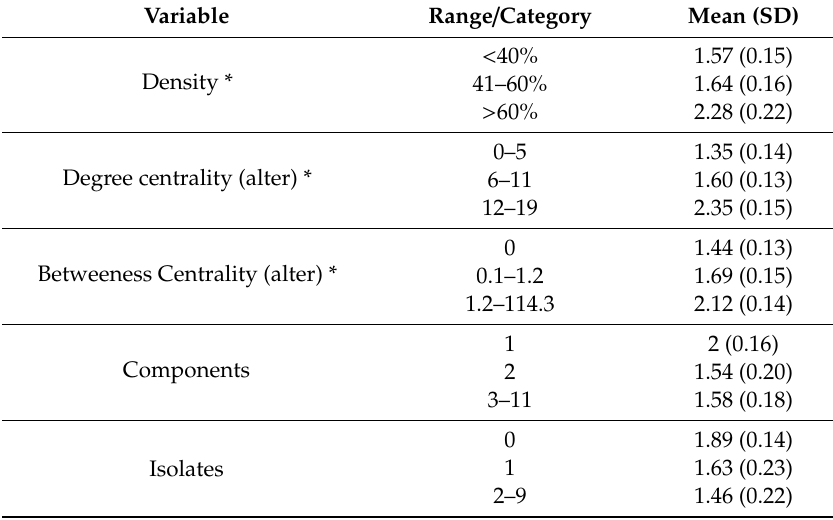
Table 2. Satisfaction and structure variables of the personal network and